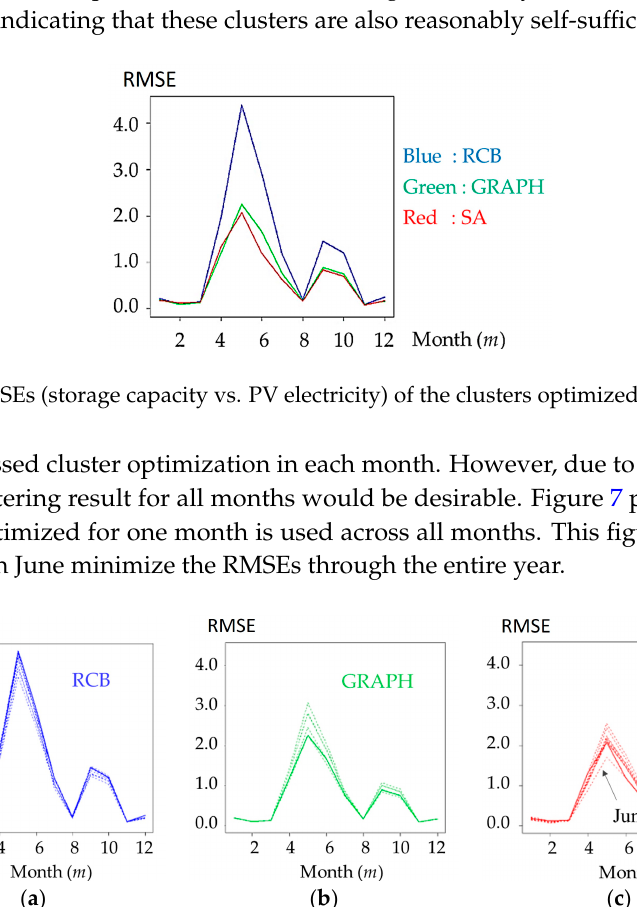
Figure 7. RMSEs (storage capacity vs. PV electricity) of the month-wise optimized clusters (solid lines) and of the clusters from a given month applied to all months (dashed lines). ( a – c ) denote results of RCB, GRAPH, and SA algorithms, respectively.